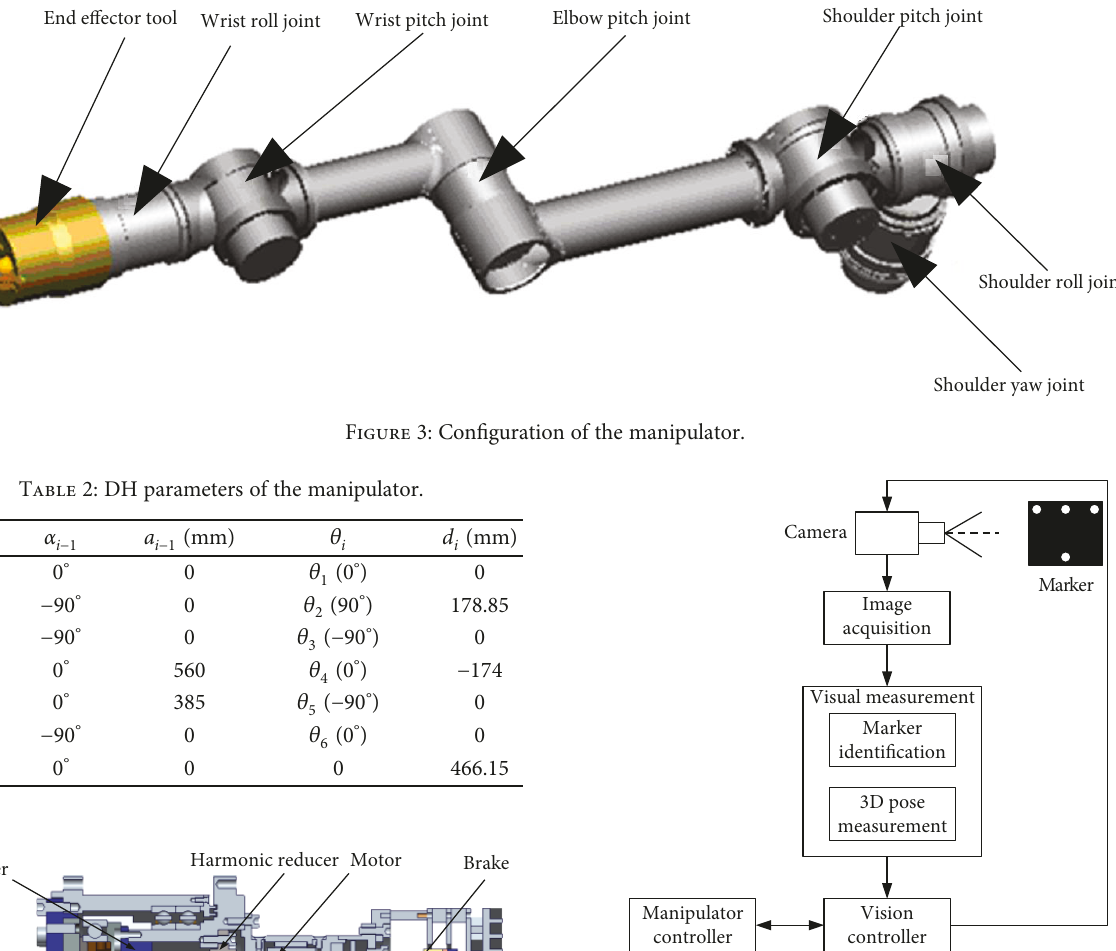
Figure 5: Vision system work fl ow of the manipulator.